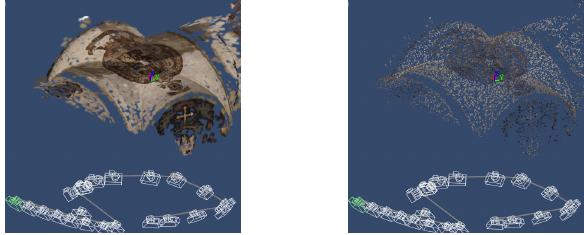
Figure(s) 15-16. Archiginnasio Rib Vault, Bologna,